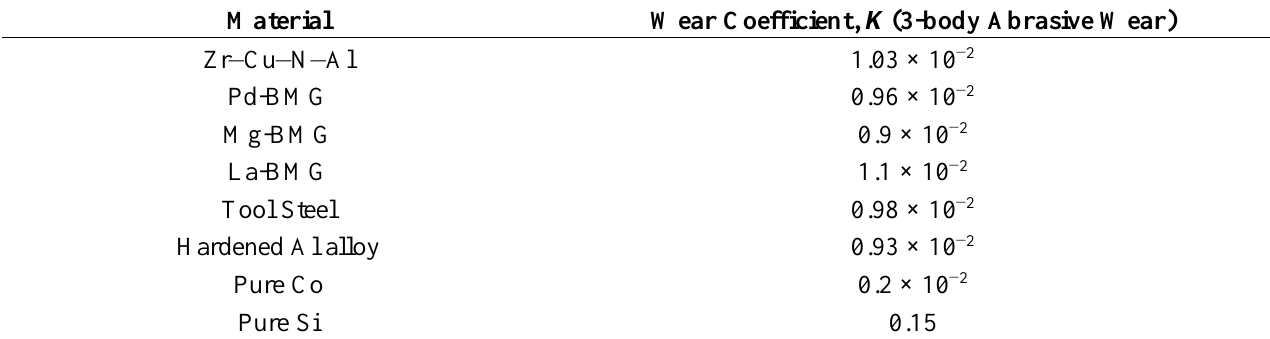
Figure 3. Correlation of the abrasive wear resistance with hardness for several different material classes [10,64]. Colored oval symbols show data for the bulk glasses with the alloy system being represented by the main element, e.g., Zr for Zr-based BMGs, etc. Within each class of material, the wear resistance scales linearly with hardness. All BMGs lie in the category of hardened alloys instead of ceramics. Table 2. Dimensionless Wear Coefficients for selected materials shown in Figure